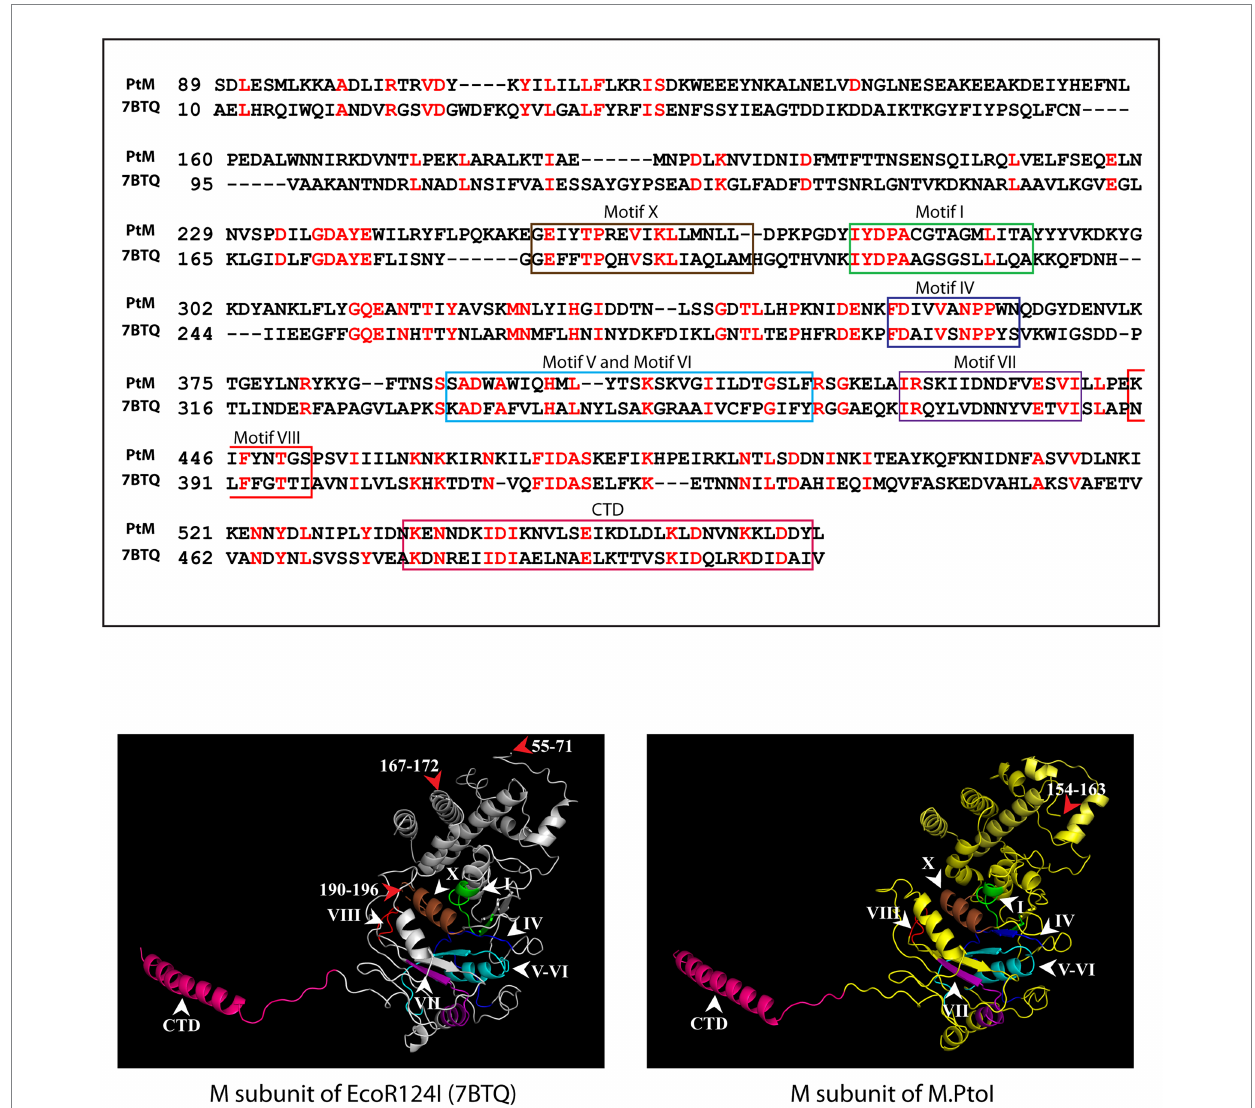
FIGURE 3 Structural analysis of M subunit of M.PtoI: Upper panel: Alignment of sequence of M subunit of M.PtoI with M subunit of EcoR124I, using Phyre2. The boxes demarcate the positions of the motifs conserved between the two subunits. CTD: C-terminal domain. Lower left panel: Ribbon representation derived from cryo-EM structure (4.54 Å) of EcoR124I [pdb ID: 7BTQ reported by Gao et al. (2020)]. Lower right panel: Ribbon representation of 3D model of M subunit of M.PtoI, modelled against the M subunit of EcoR124I (7BTQ) as template using Phyre2. CTD: C-terminal domain. Roman numerals indicate motif positions. Arabic numerals depict amino acid residues that were excluded from the